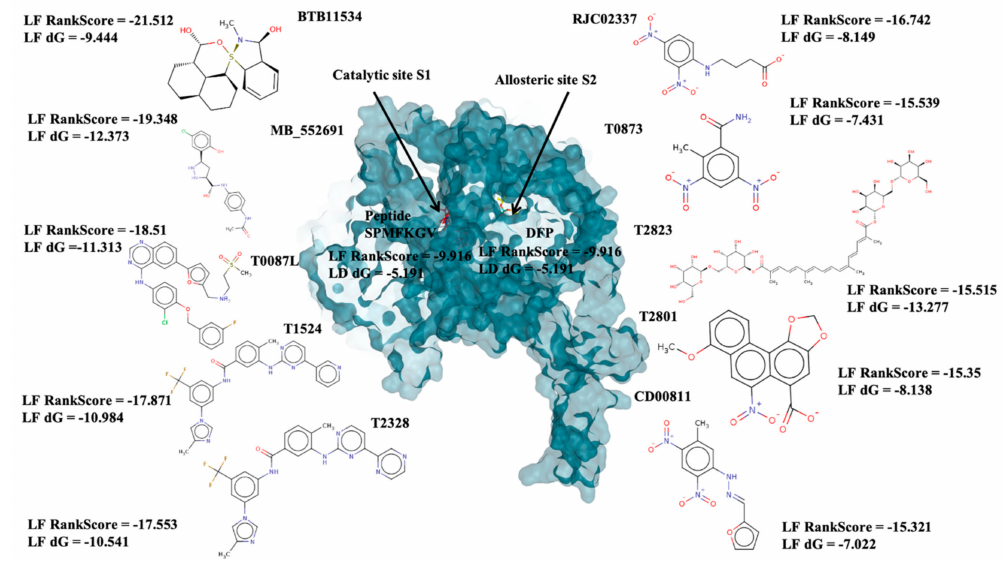
Figure 6. The depiction of the allosteric and catalytic pocket of PfDegP in bound confirmation with DFP and peptide SPMFKGV and the top 5 screened compounds of both the pockets with their binding score (LF Rank Score) and binding affinity